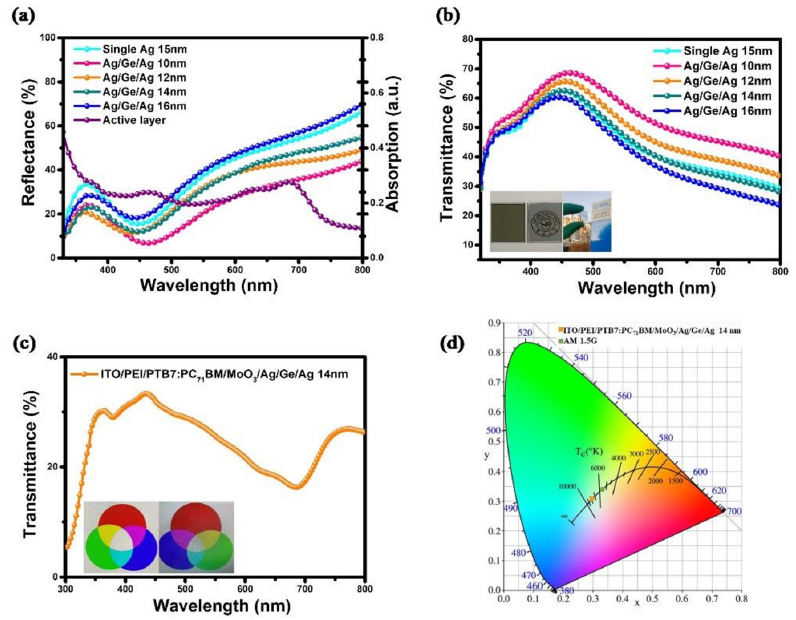
Figure 5. ( a ) Reflectance spectra and ( b ) transmittance spectra of the semitransparent electrode Ag/Ge/Ag (10, 12, 14, and 16 nm). ( c ) Transmittance spectrum of the semitransparent device with the Ag/Ge/Ag (14 nm) electrode. ( d ) Color coordinates of devices on the CIE xy 1931 chromatic- ity